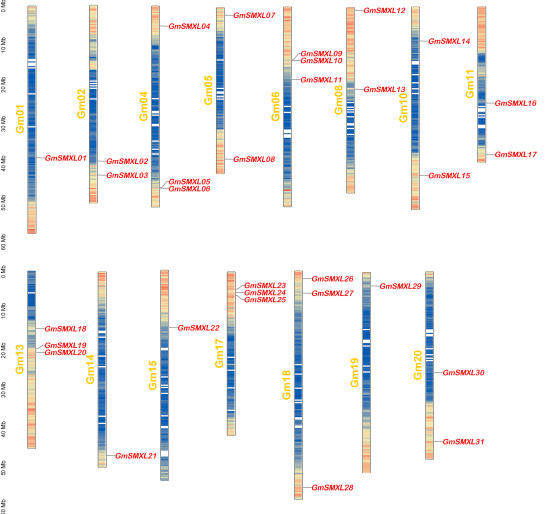
Figure 3. Chromosomal distributions of GmSMXL genes. The names of the SMXL genes are labeled at the appropriate position on the right side of each soybean chromosome. The gene density of each chromosome was illustrated by gradient colors, blue represents low gene density, red represents high gene density, and the genetic interval was set to 300 kb for